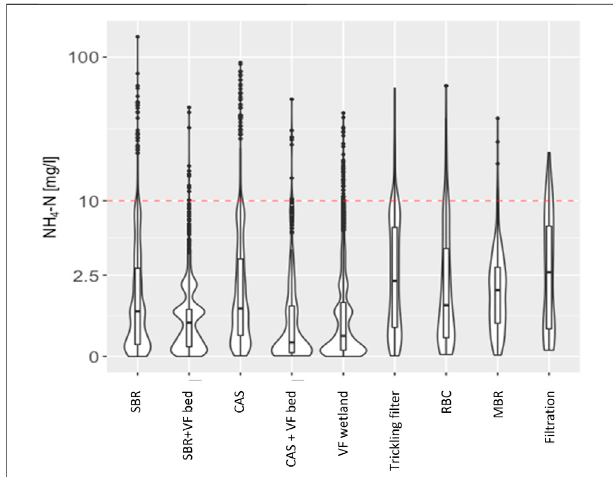
FIGURE 3 | Violin plot of NH 4 -N ef fl uent concentrations for various technologies (red dashed line: threshold value of 10 mg NH 4 -N/L). Violin plots visualizethedistributionofnumericaldatabydepictingsummarystatisticsand the density of each variable.